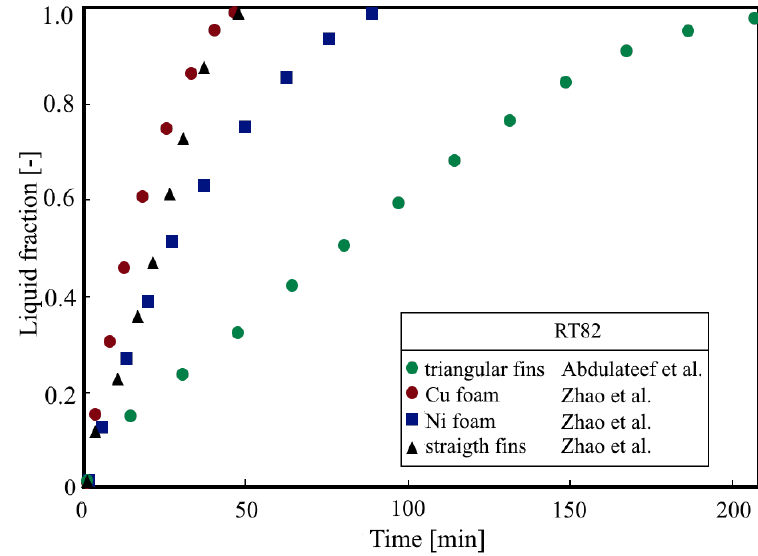
Figure 12. Liquid fraction distribution for TTH TESU